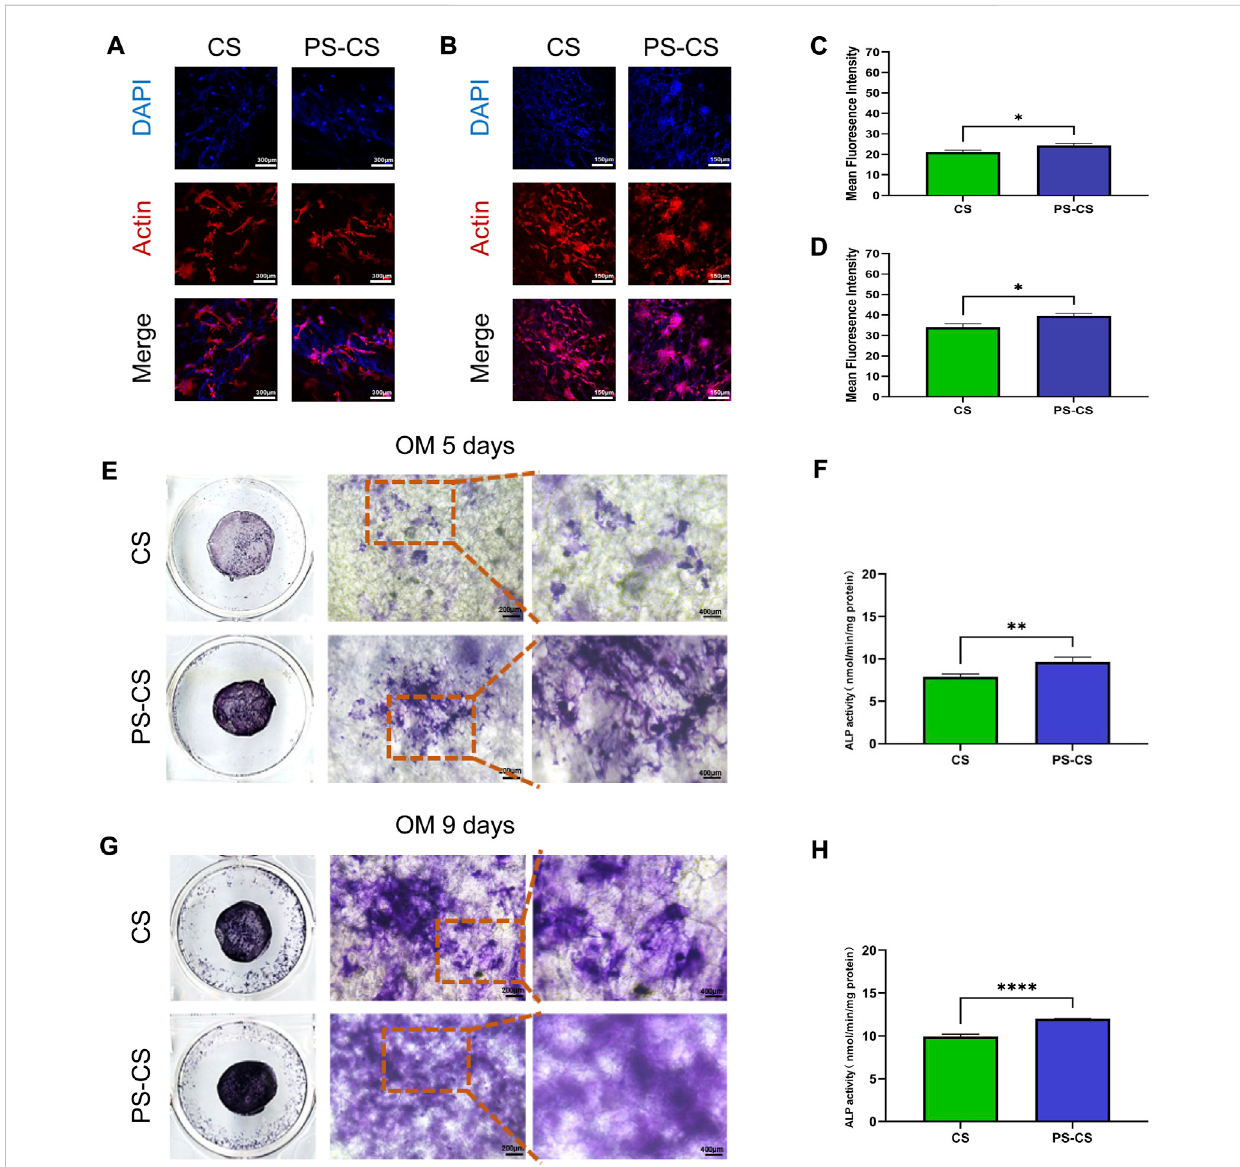
FIGURE 4 Cell attachment assay. (A, B) Fluorescent staining of cultured cells over the membrane after culturing for 24 h (A) , 7 days (B) . Red, cytoskeleton stained by rhodamine phalloidin; Blue, nuclei stained by DAPI. (C, D) Quantitative analysis of the fl uorescent intensity after cell attachment on the scaffolds at 24 h (C) , and 7 days (D) post seeding. Effect of CS membranes (CS) and phosphoserine-chitosan membranes (PS-CS) on ALP activity and mineralizationinBMSCs. (E,G) ALPstainingofBMSCsafterculturedwithmembranesfor5 days (E) ,9 days (G) . (F,H) ALPactivitiesofBMSCscultured on different membranes for 5 days (F) and 9 days (H) . The data were analyzed statistically using analysis of variance (ANOVA). * p < 0.05; ** p < 0.01; and *** p < 0.001, **** p <